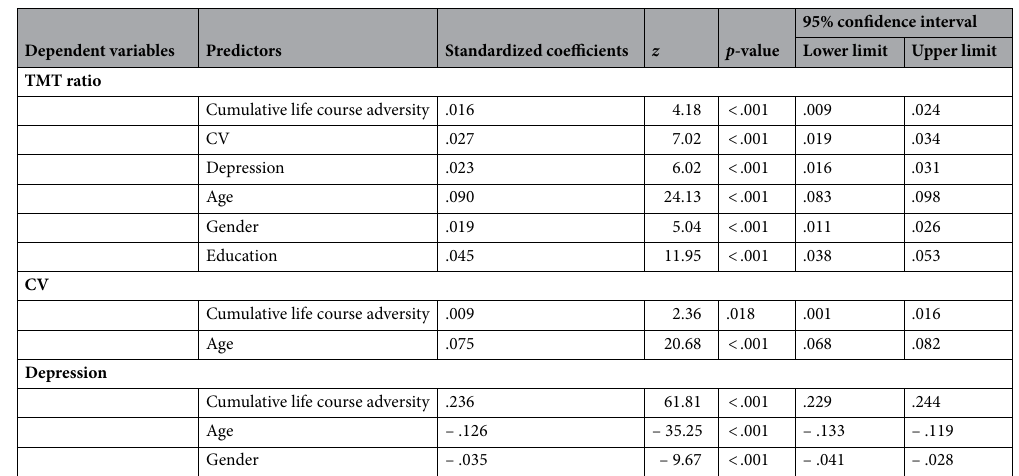
Table 4. Standardized coefficients of the model, with z , p -value, and associated 95% confidence interval. CV Coefficient of variation, TMT Trail Making Test.